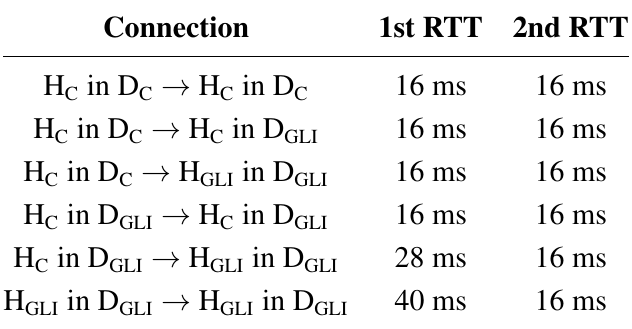
) or classic domains (D GLI